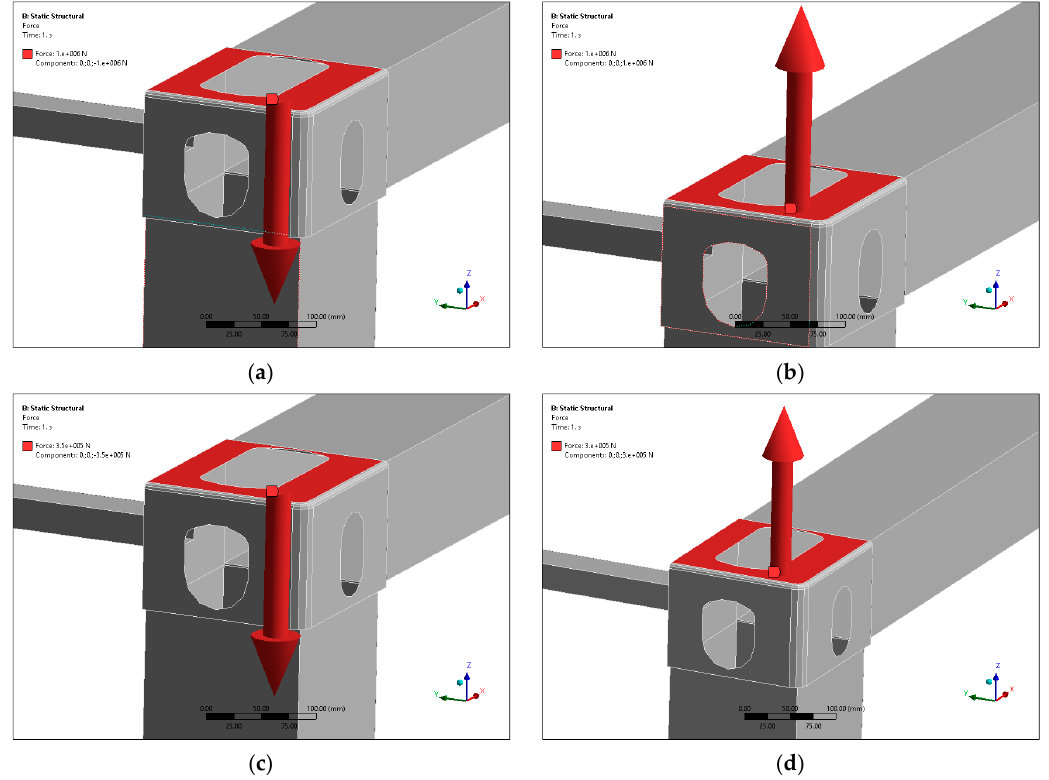
Figure 5. Force directions. ( a ) Stacking: ~100 tons (1000 kN) negative Z direction, ( b ) lifting: ~100 tons (1000 kN) plus Z direction, ( c ) stacking: ~35 tons (350 kN) negative Z direction, and ( d ) lifting: ~30 tons (300 kN) plus Z direction.